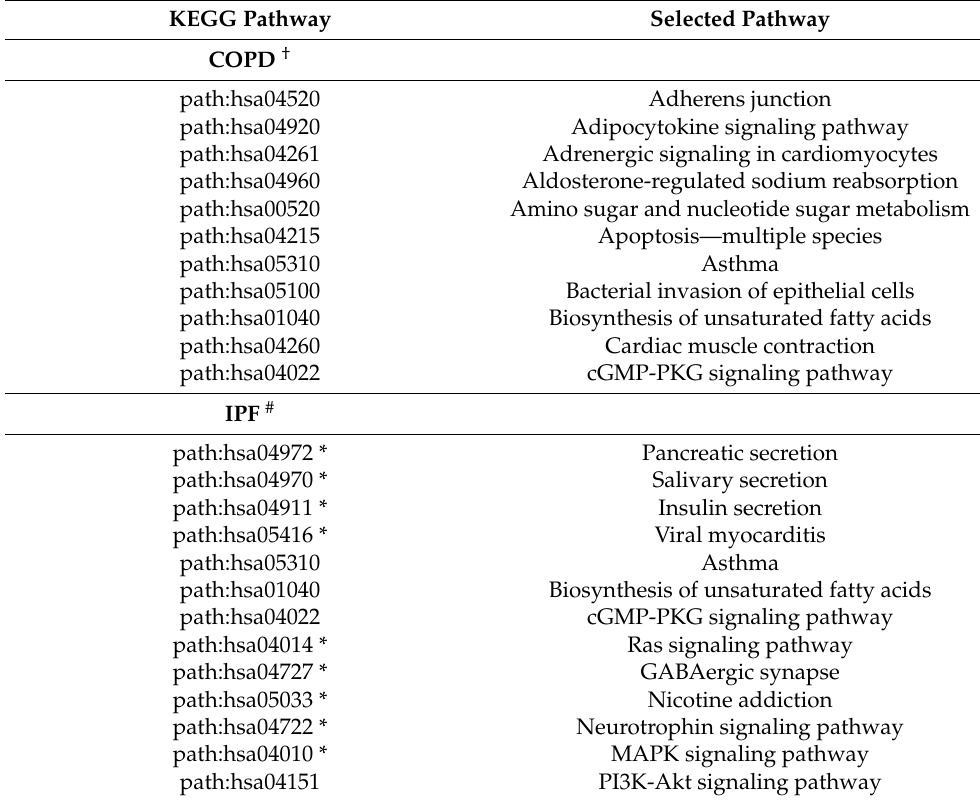
Table 4. KEGG analyses of differentially expressed miRNAs in lung-tissue-derived exosomes from COPD and IPF